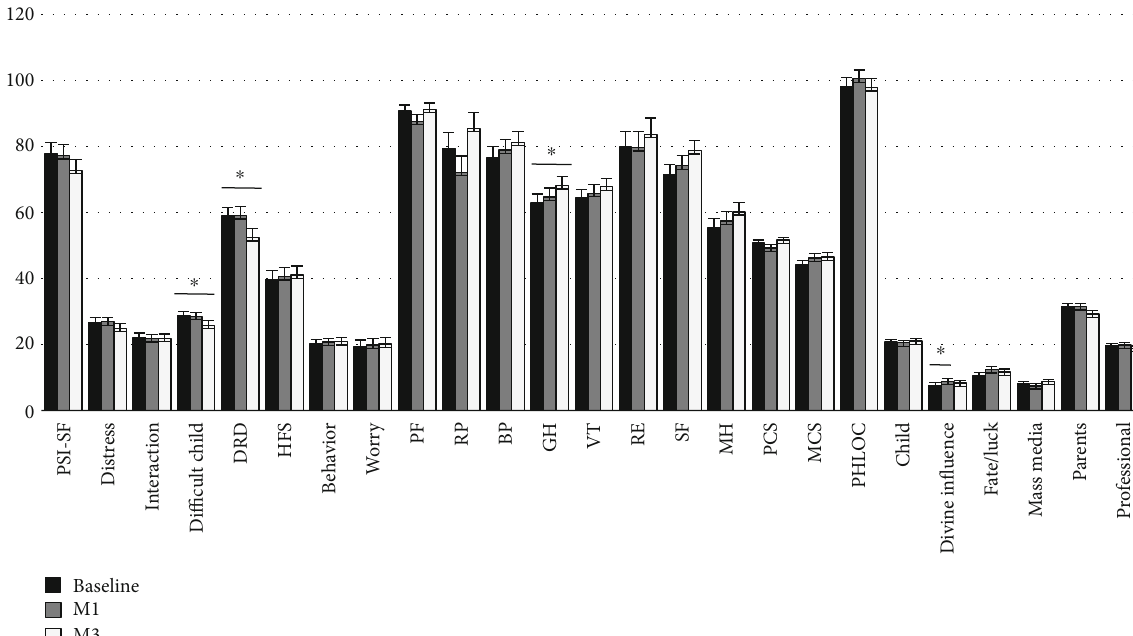
Figure 1: Estimated mean scores in mothers. Asterisks indicate signi fi cant di ff erences between species (planned comparisons; ∗∗∗ p < 0 : 05 ). Abbreviations: M1 — after one month; M3 — after three months; PSI-SF — Parenting Stress Index Short Form; DRD — Diabetes-Related Distress; HSF — Hypoglycemia Fear Survey; PF — physical function; RP — role limitations due to physical problems; BP — bodily